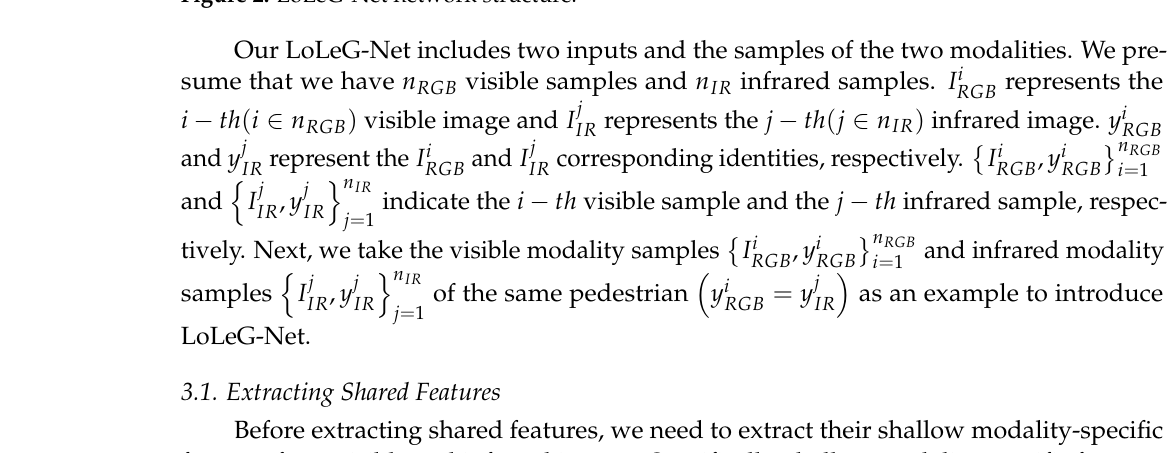
Figure 2. LoLeG-Net network structure.